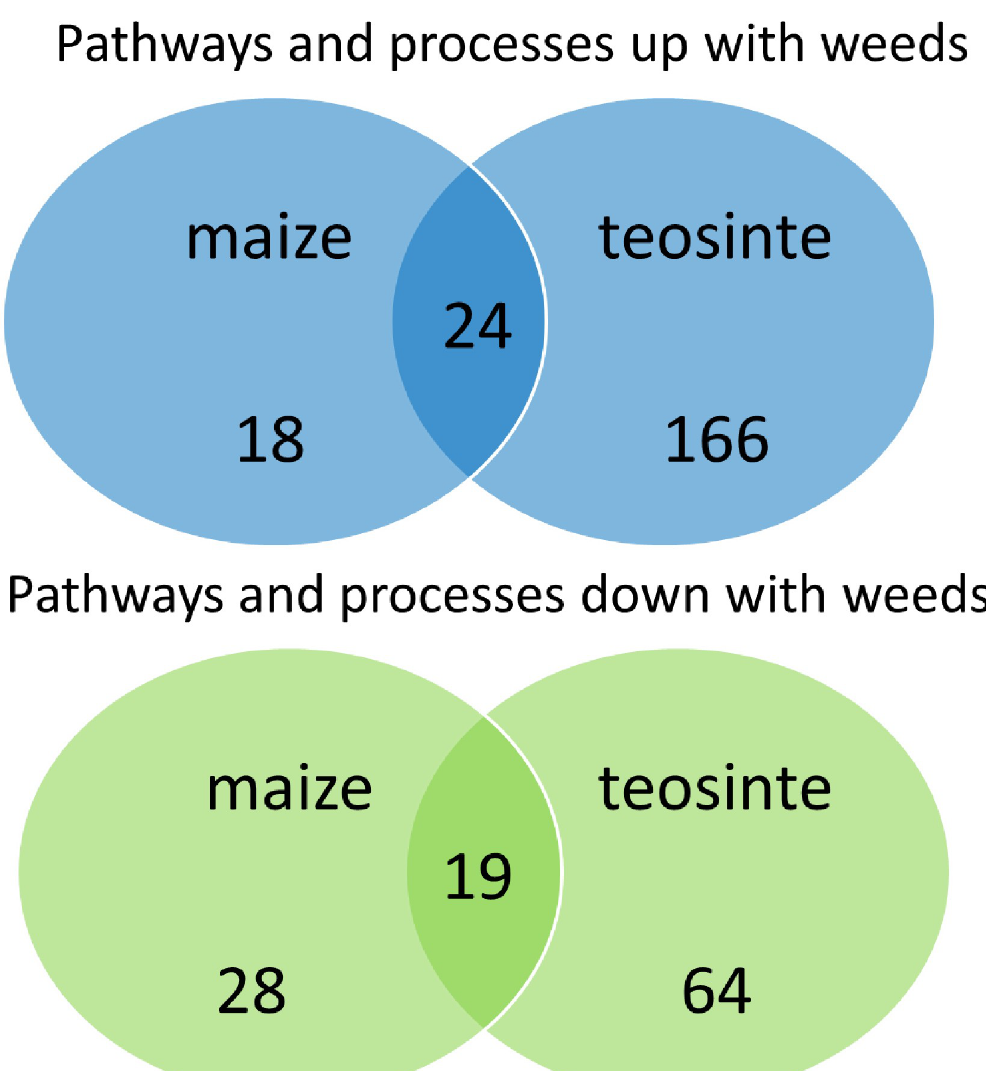
Fig 6. Venn diagram indicating similarities and overlaps among gene ontologies. “Up with weeds” and “down with weeds” refer ontologies over-represented among genes that were up-regulated by weed interference or down-regulated by weed interference respectively in maize and/or teosinte as